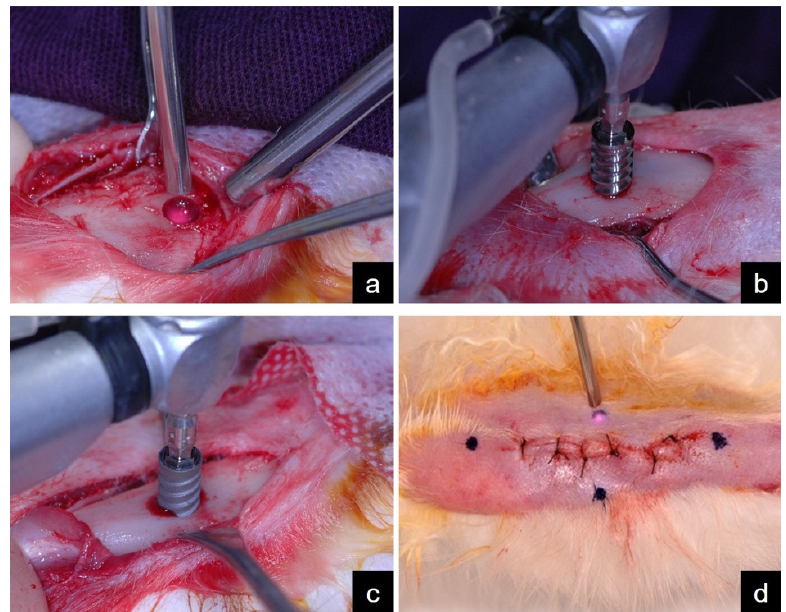
Figure 2. Experimental surgery: ( a ) PBM therapy in the surgical site (LMS and LTS groups); ( b ) Installation of machined surface implant; ( c ) Installation of surface ‐ treated implant; ( d ) PBM therapy in four points after suture (LMS and LTS groups).